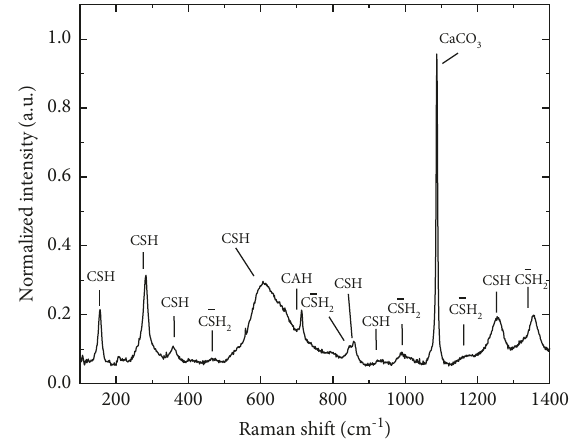
Figure 2: Experimentally obtained spectrum from a control sample of cement paste. The vibrational mode contributed by different phases present in the paste is